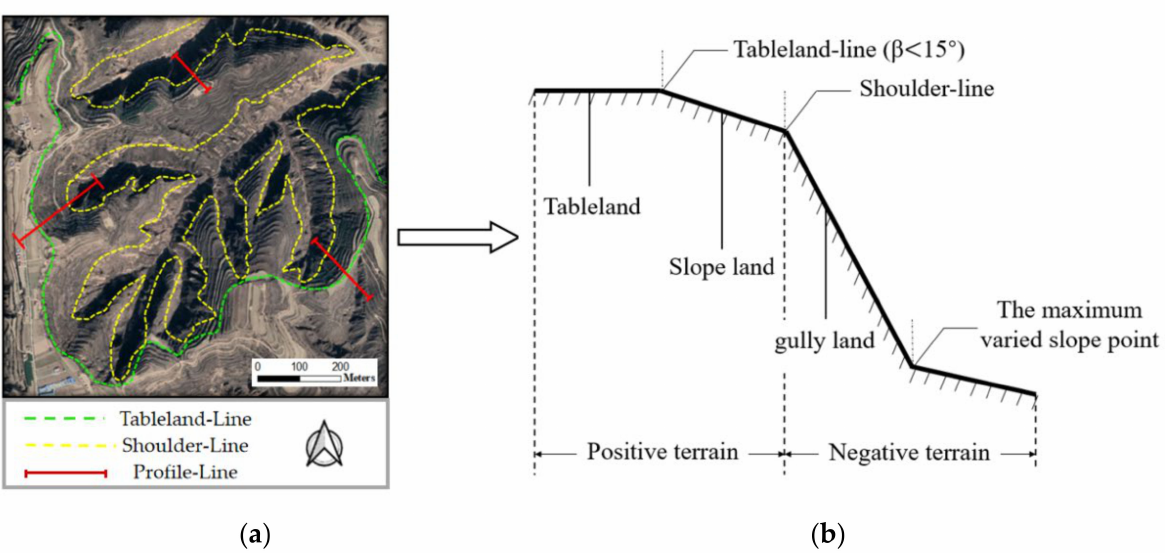
Figure 3. Location of the shoulder line in a typical profile: ( a ) planar graph provided by Google Earth; ( b ) a typical profile.